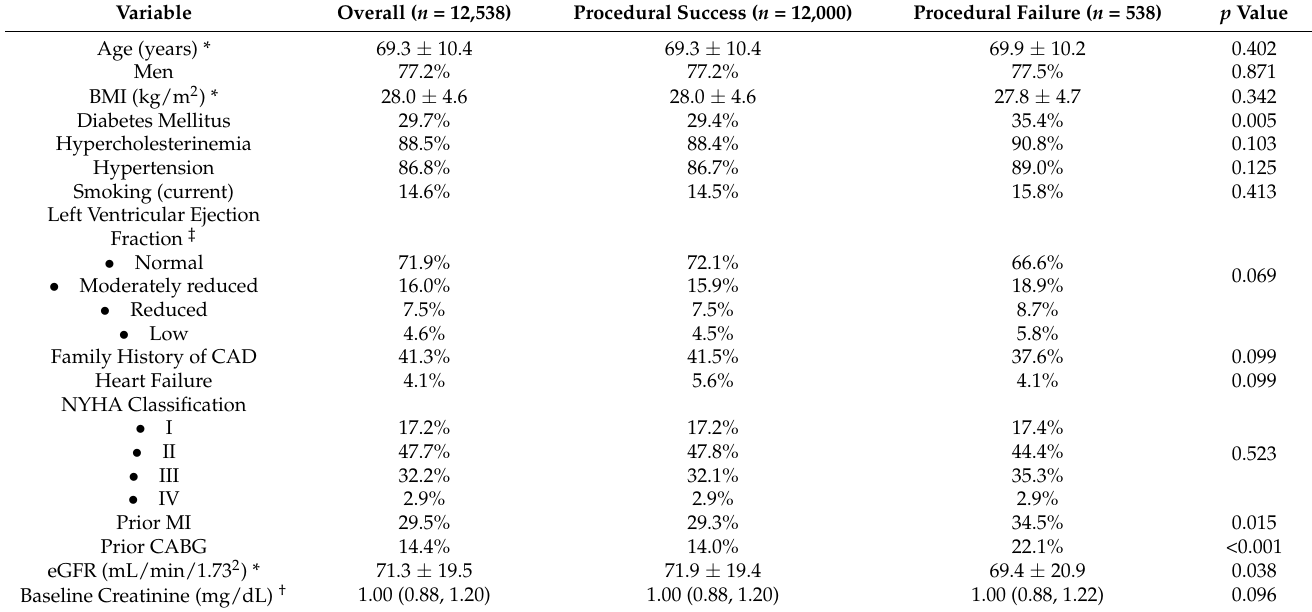
Table 1. Clinical characteristics of patient undergoing percutaneous coronary intervention (PCI) for stable coronary artery disease (CAD) categorized according to procedural